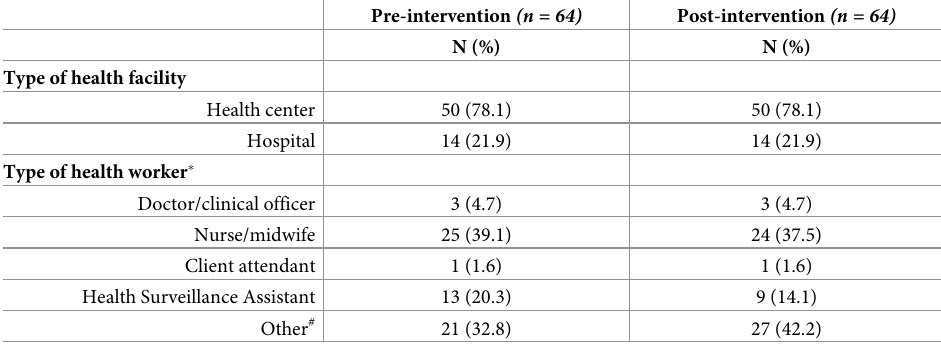
Table 4. Characteristics of HCWs completing collective action surveys, pre- and post-